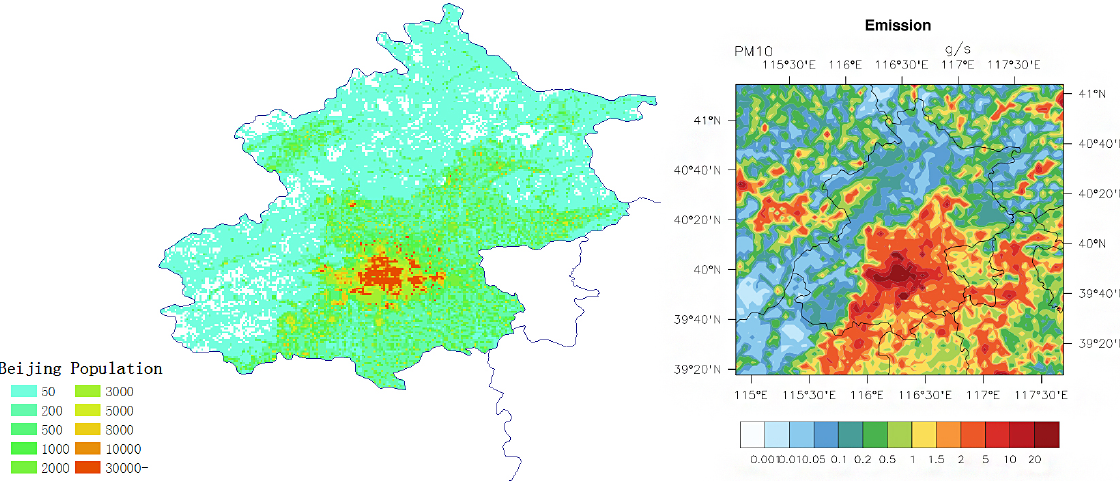
Figure 3. The SMOKE area emissions are spatially allocated based on a related spatial factor, such as population data from the Land Scan 2005 Global Population Database ( Dobson et al., 2000). The left panel shows the spatial distribution of the population in Beijing Municipality in the Land Scan 2005; the right panel shows the spatial distribution of PM 10 emissions in the inner domain in the forecast